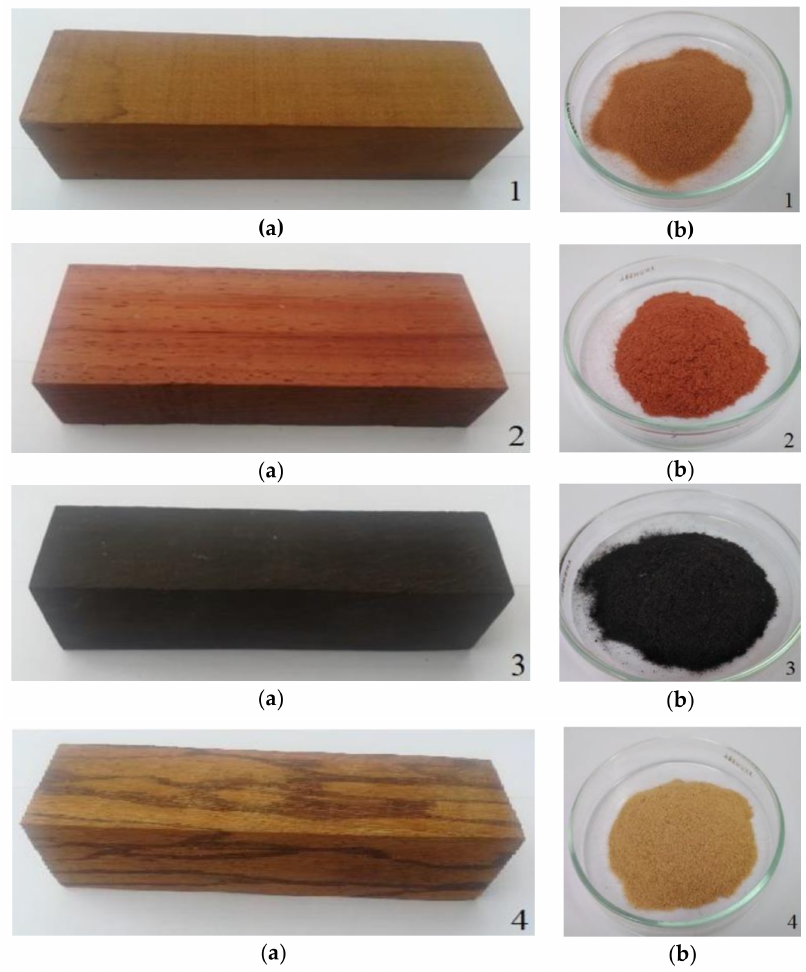
Figure 1. Experimental samples ( a ) in the form of plates; ( b ) in the form of prepared wood dust. The legend: (1) Cumaru ( Dipteryx odorata ); (2) African Parakeet ( Pterocarpus soyauxii ); (3) African Ebony ( Diospyros crassiflora ), and (4) Marblewood ( Marmaroxylon racemosum